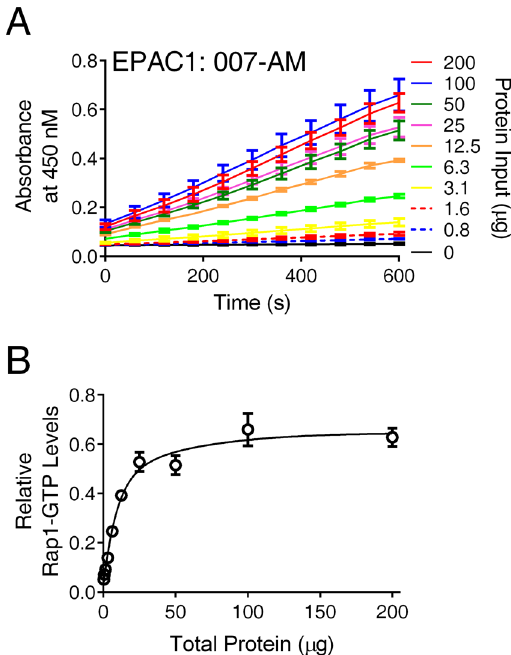
Figure 2. Relative signals of EPAC1-mediated Rap1 cellular activation as function of amount of lysate proteins. ( A ) Time course of EPAC1-mediated Rap1 activation in response to 1 µ M of 007-AM measured using